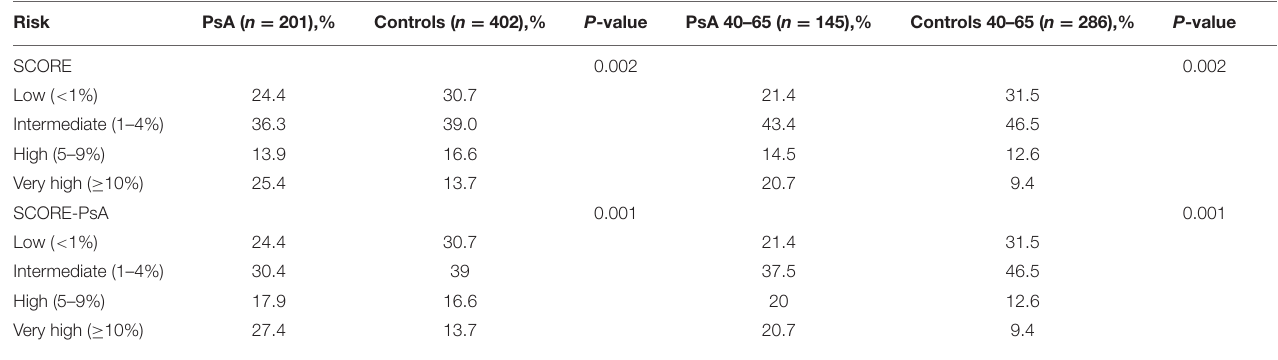
TABLE 3 | Cardiovascular risk according to the SCORE and SCORE-PsA